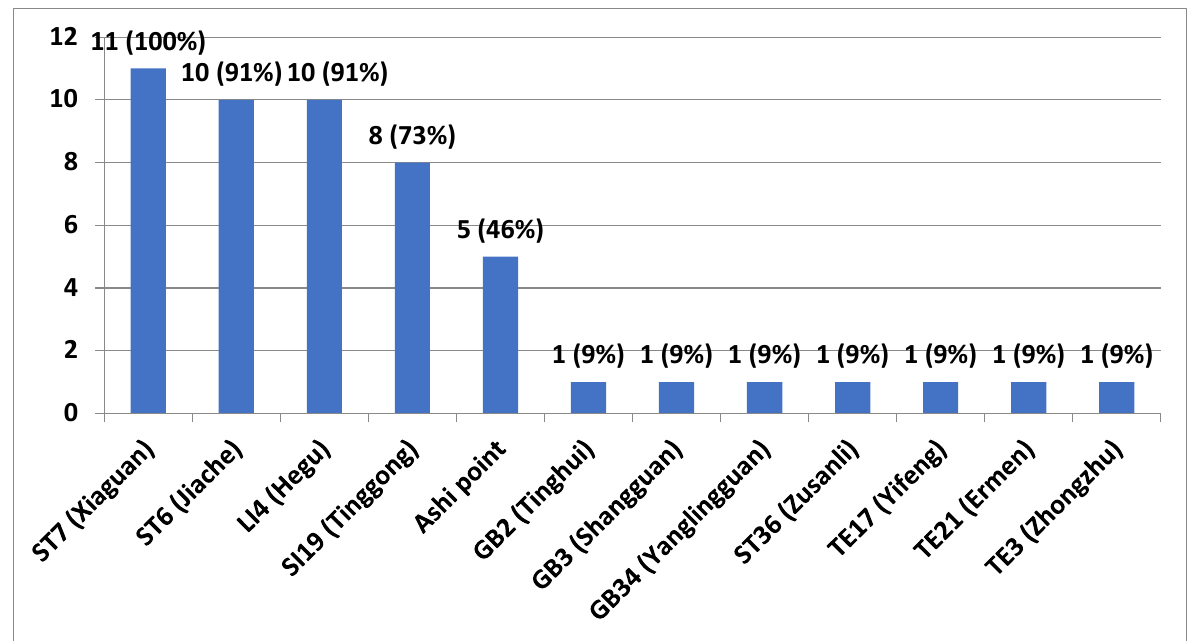
Figure 2. The acupuncture points utilized in these studies.